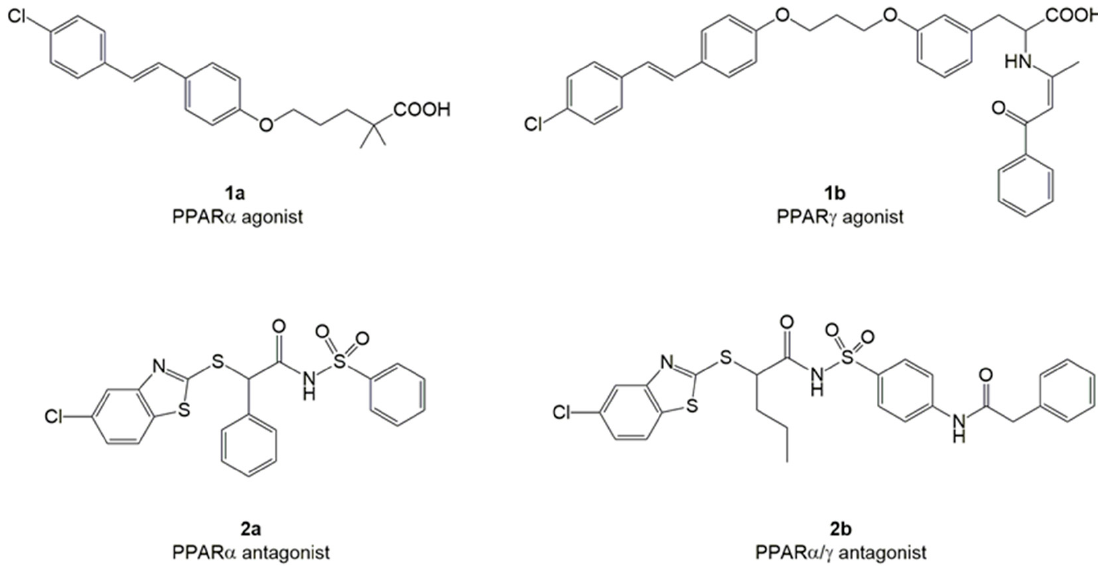
Figure 1. The chemical structures of PPAR agonists ( 1a ‐ b ) and antagonists ( 2a ‐ b ).